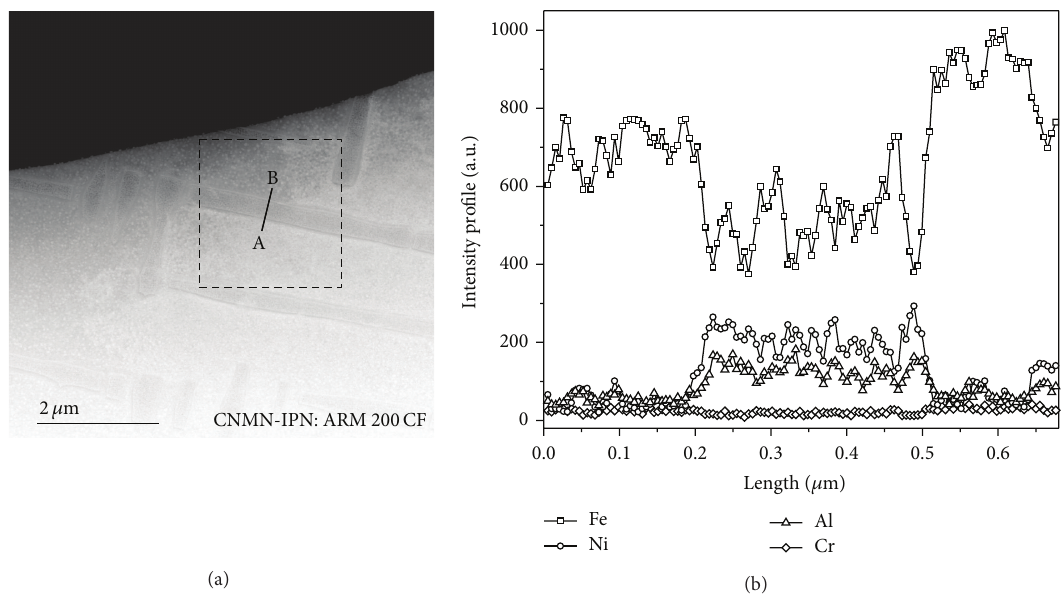
Figure 5: (a) HAADF-STEM image of (Fe, Ni)Al precipitates in a Fe matrix and (b) intensity profile of Fe, Ni, Al, and Cr elements.